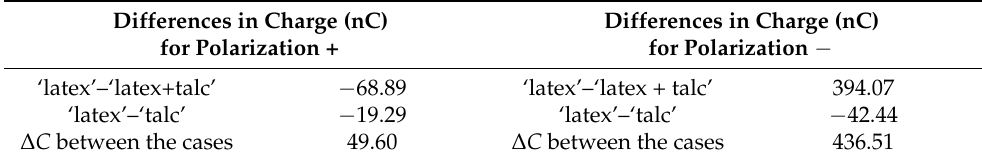
Table 1. Maximum accumulated electric charge differences for different comparison cases and polarizations. Case denoted as 1 in Equation (1) is ‘latex’ in all